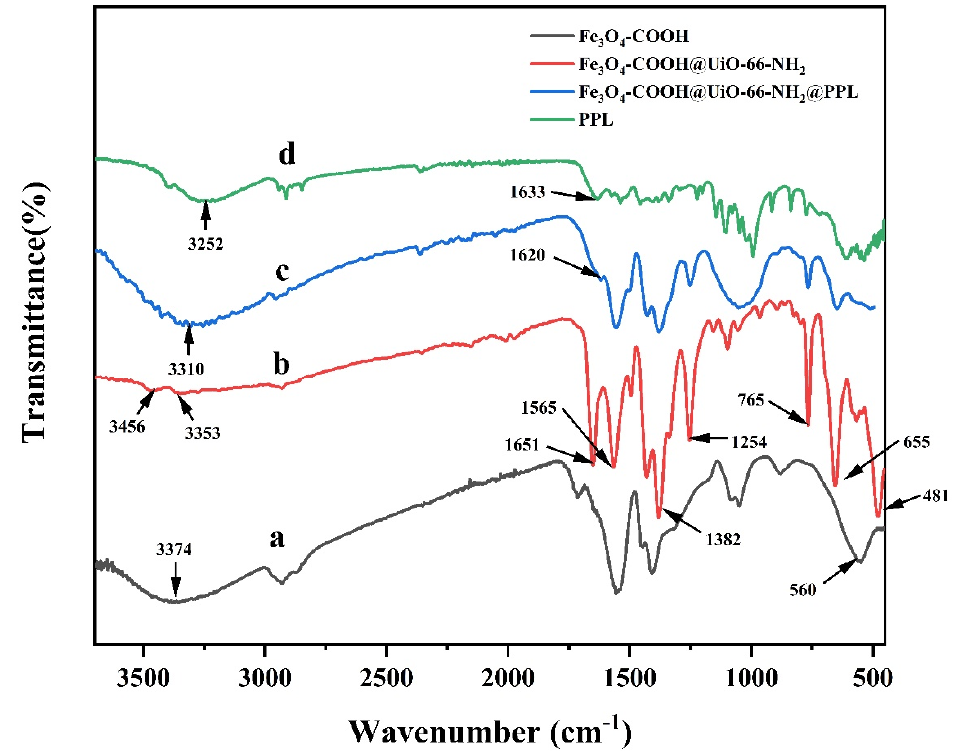
Figure 2. The FT-IR spectra of Fe 3 O 4 -COOH ( a ), Fe 3 O 4 -COOH@UiO-66-NH 2 ( b ), Fe 3 O 4 -COOH@UiO- 66-NH 2 @PPL ( c ), and PPL ( d ).